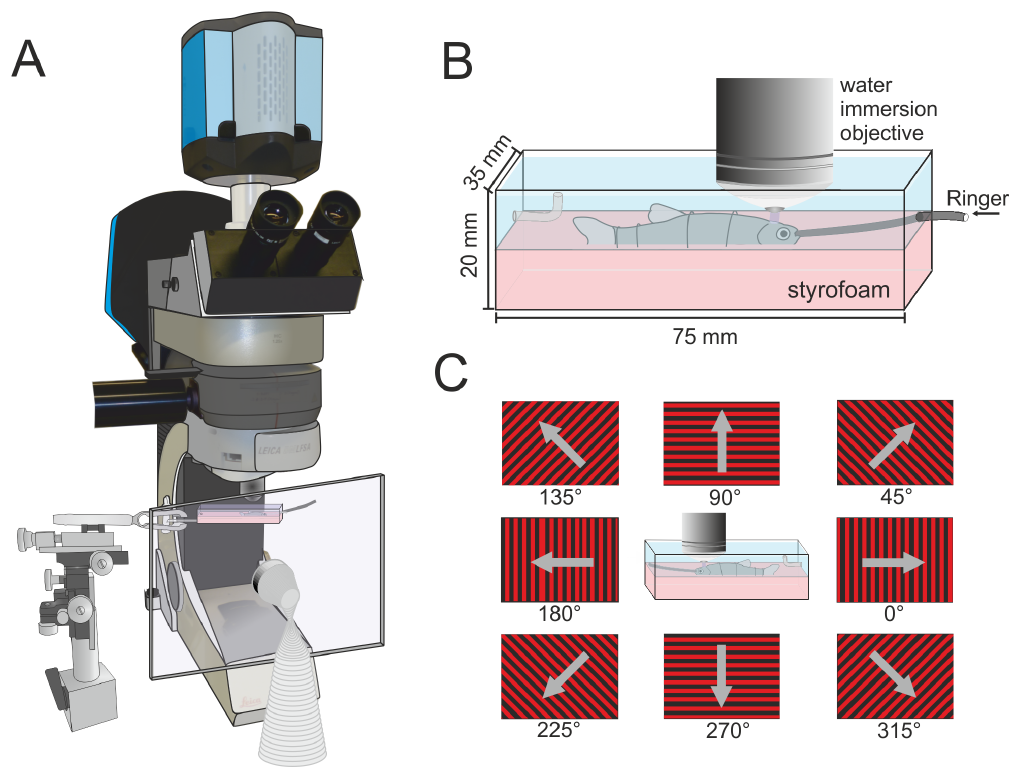
Figure 1. Schematic drawing of the experimental set-up. A. The animal was placed under a standard upright fixed-stage microscope, equipped with a sensitive electron-multiplying CCD camera and LED-based epifluorescence illumination. To deliver visual stimuli, we used a TFT screen, which was placed in front of the eye facing the experimenter (drawn transparent for clarity). B. Detailed view of the recording chamber. Fish were placed on a styrofoam support tray and held in place by tungsten wires bent to support the animals. The chamber was continuously perfused with Hickmann ringer. C. Schematic display of the grating stimulus used for the determination of orientation and directional selectivity of tectal cells. For all data the denomination of the motion directions corresponds to the one shown